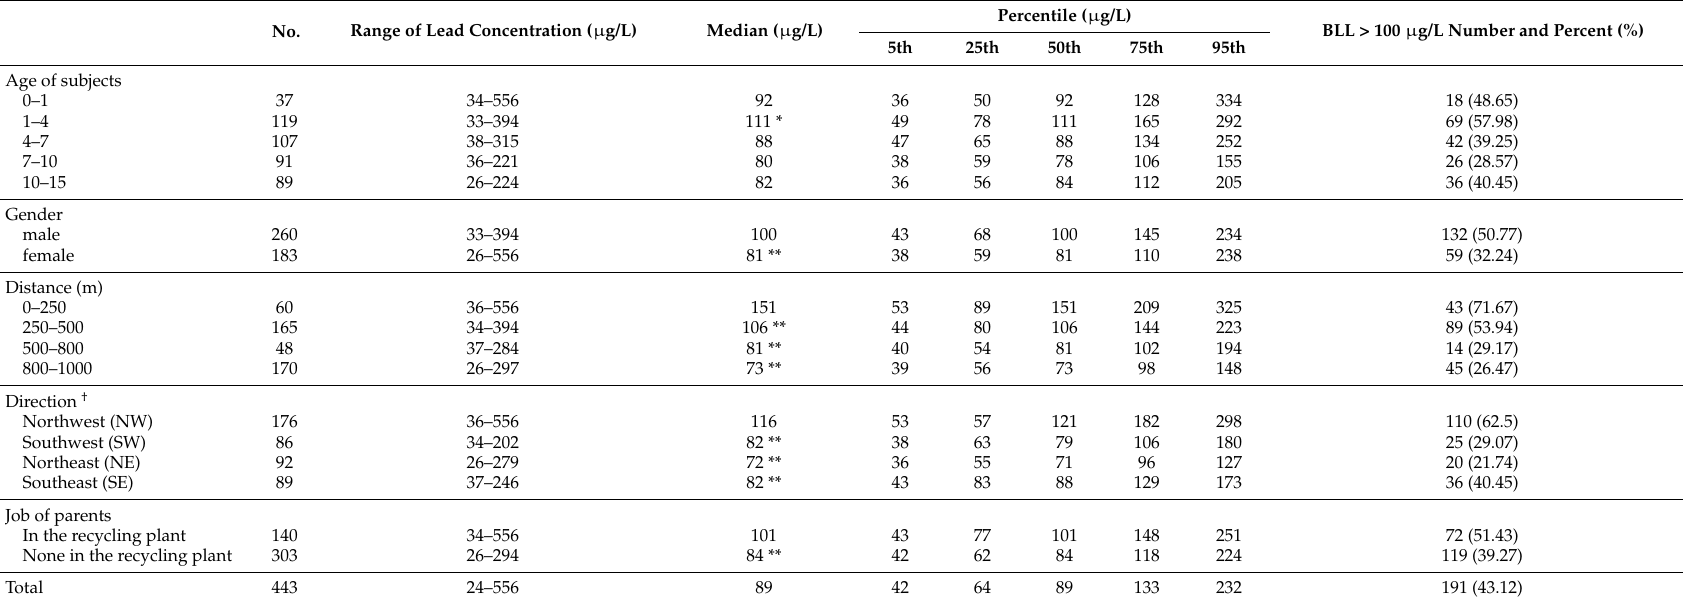
Table 3. Concentrations and descriptive statistics for lead in children’s